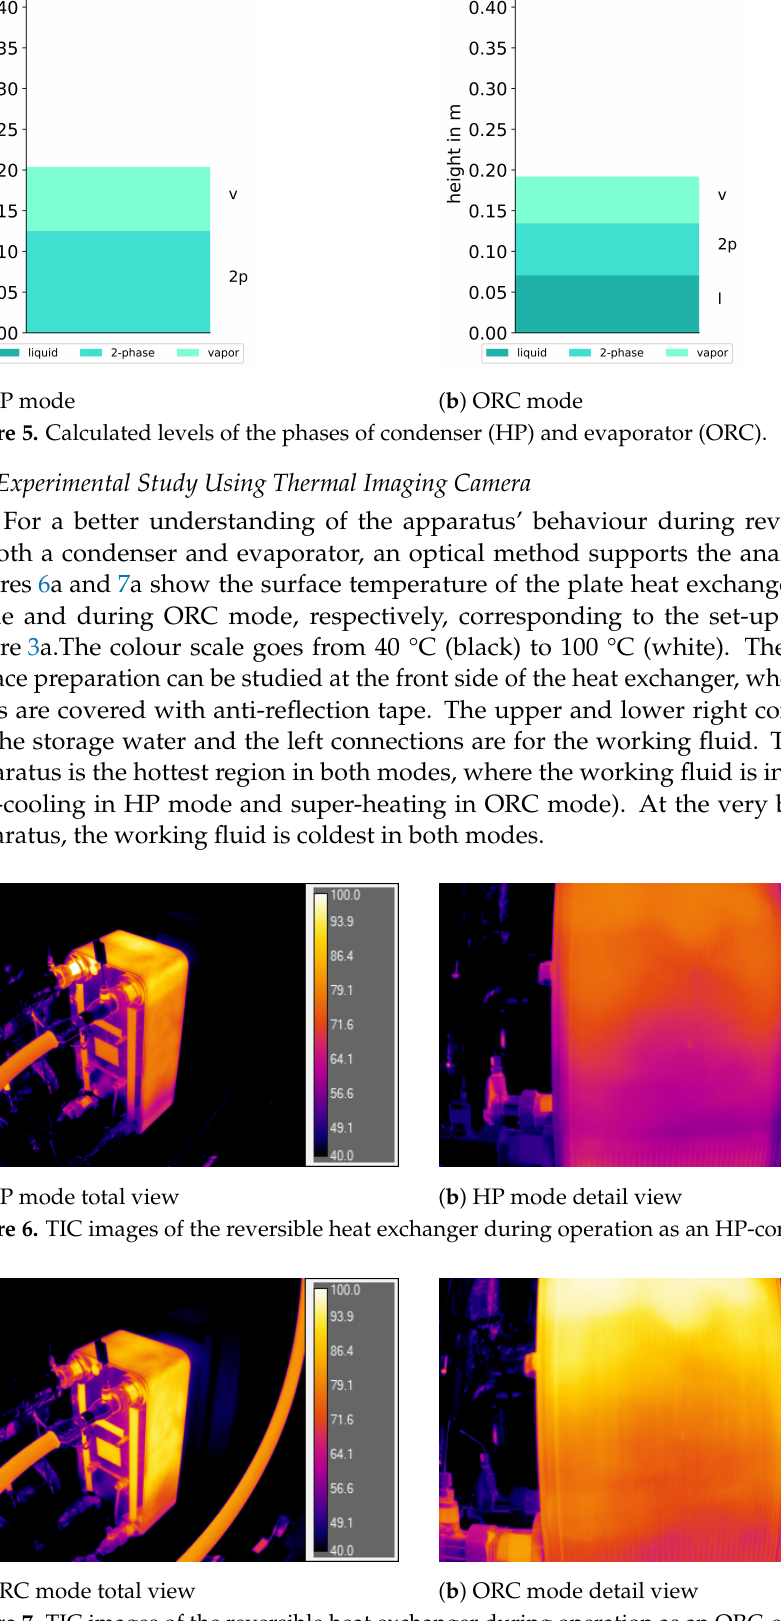
Figure 7. TIC images of the reversible heat exchanger during operation as an